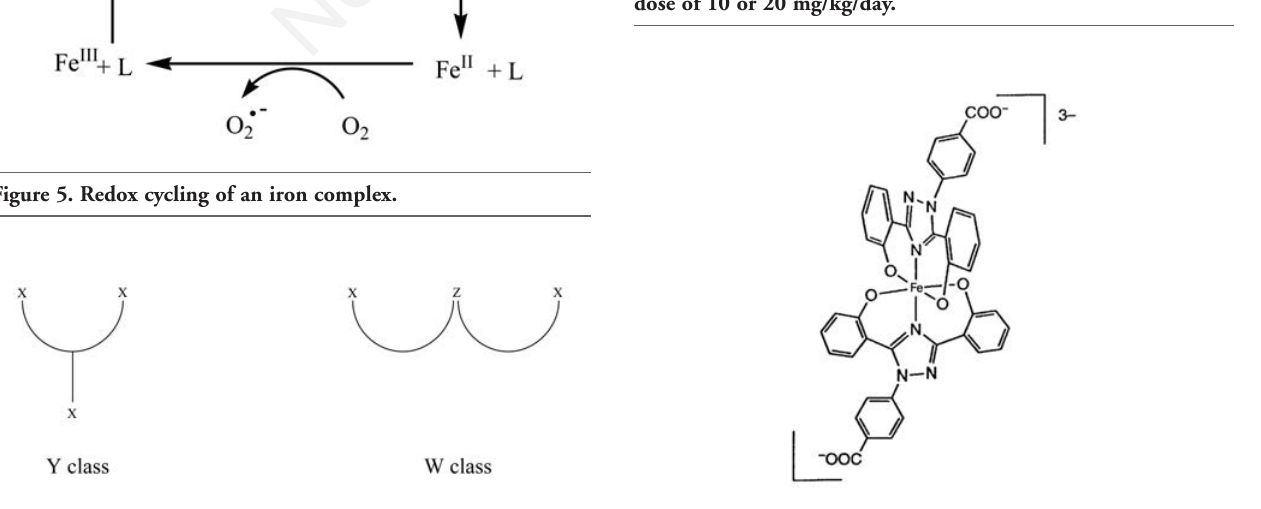
Figure 6. The design of tridentate ligands.